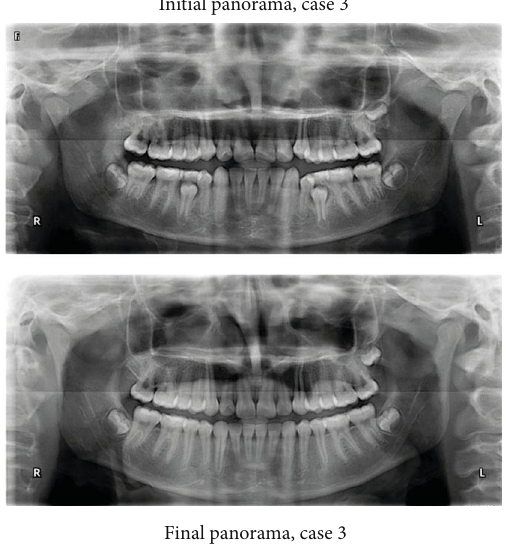
Figure 18: Initial and fi nal panoramic